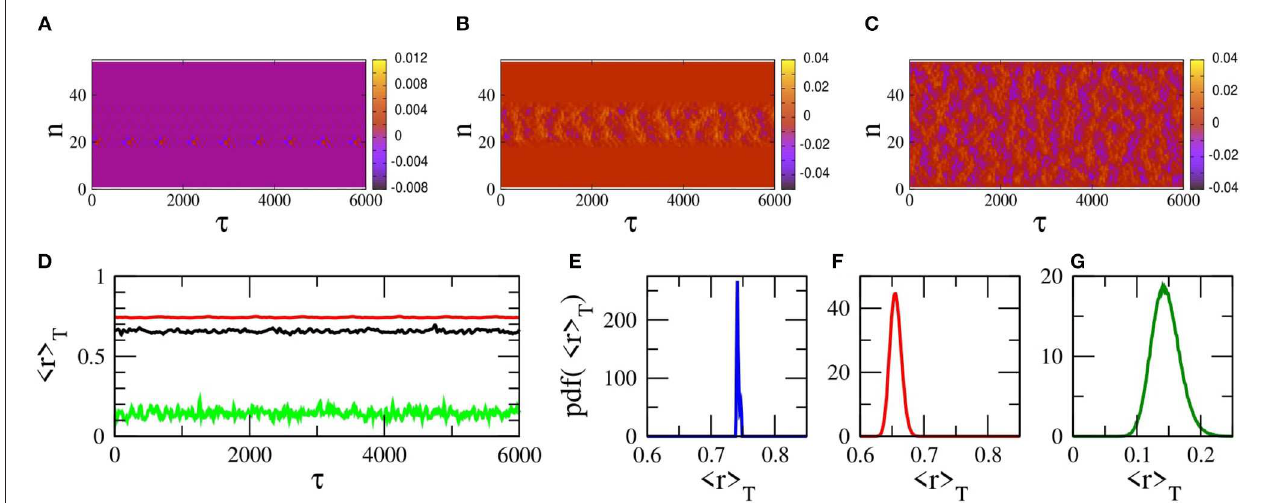
τ plane for β L on the n 0.86, γ 0.01, λ 0.02, (cid:127) 1.01, N 54, φ dc 0, φ ac 0.06, and initial conditions given by i T − = = = − = = = = 0.10. (C) Same as in (A,B) but with φ ac 0.12. (D) The magnitude of the synchronization parameter averaged over = = r , as a function of time τ for φ ac 0.06 (red), φ ac 0.1 (black), and φ ac 0.12 (green). The other parameters are as in (A) . (E) The distribution h i T = = = r r , pdf ( ), for the chimera state shown in (A) . (F) Same as in (E) for the chimera state shown in (B) . (G) Same as in (E,F) for the completely h i T h i T